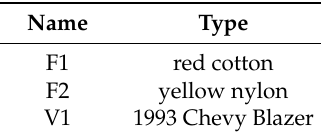
Table 1. Characteristics of the implanted target spectra in our synthetic data